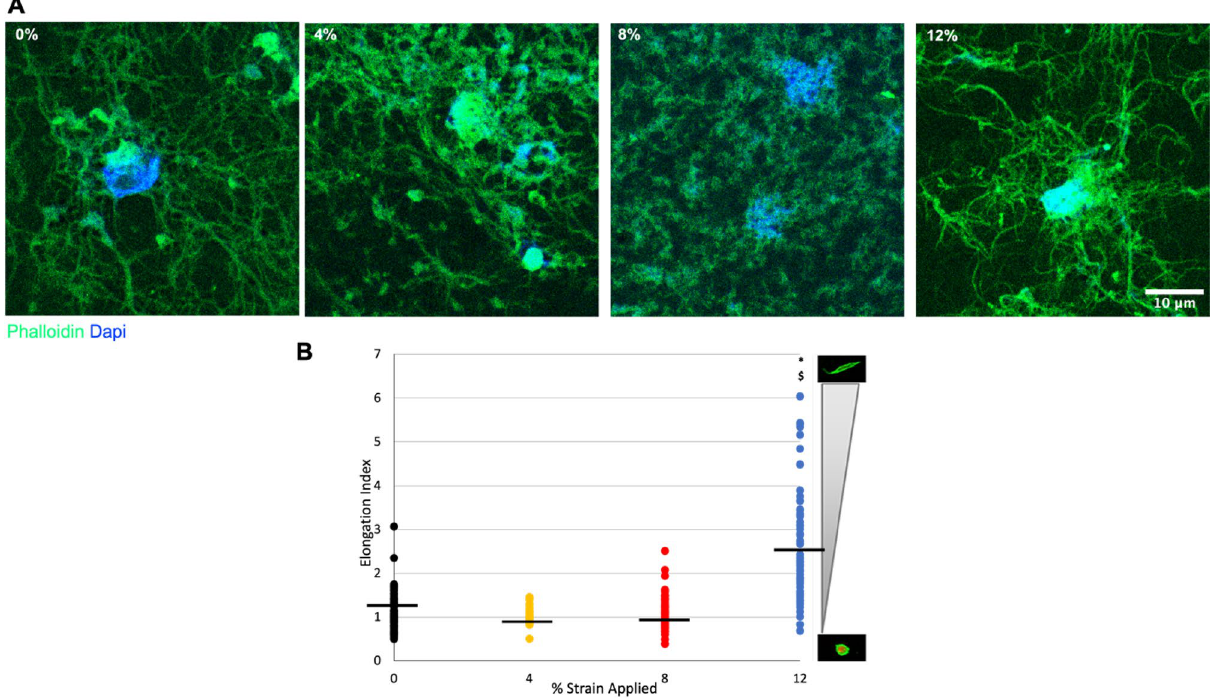
Figure 4. Cell elongation index (EI) analysis for HFF1 cells within the 3D tissue analogues after uniaxial loading. The gradient scale to the right designates the spectrum of cell measurements, with corresponding representative images of cell morphologies. *Indicates significant difference with respect to 0% mechanical strain group (control). # Represents a significant difference between 4 and 8% mechanical strain groups, § represents a significant difference between 8 and 12% strain groups, and † represents a significant difference between 4 and 12% strain groups, each with P <